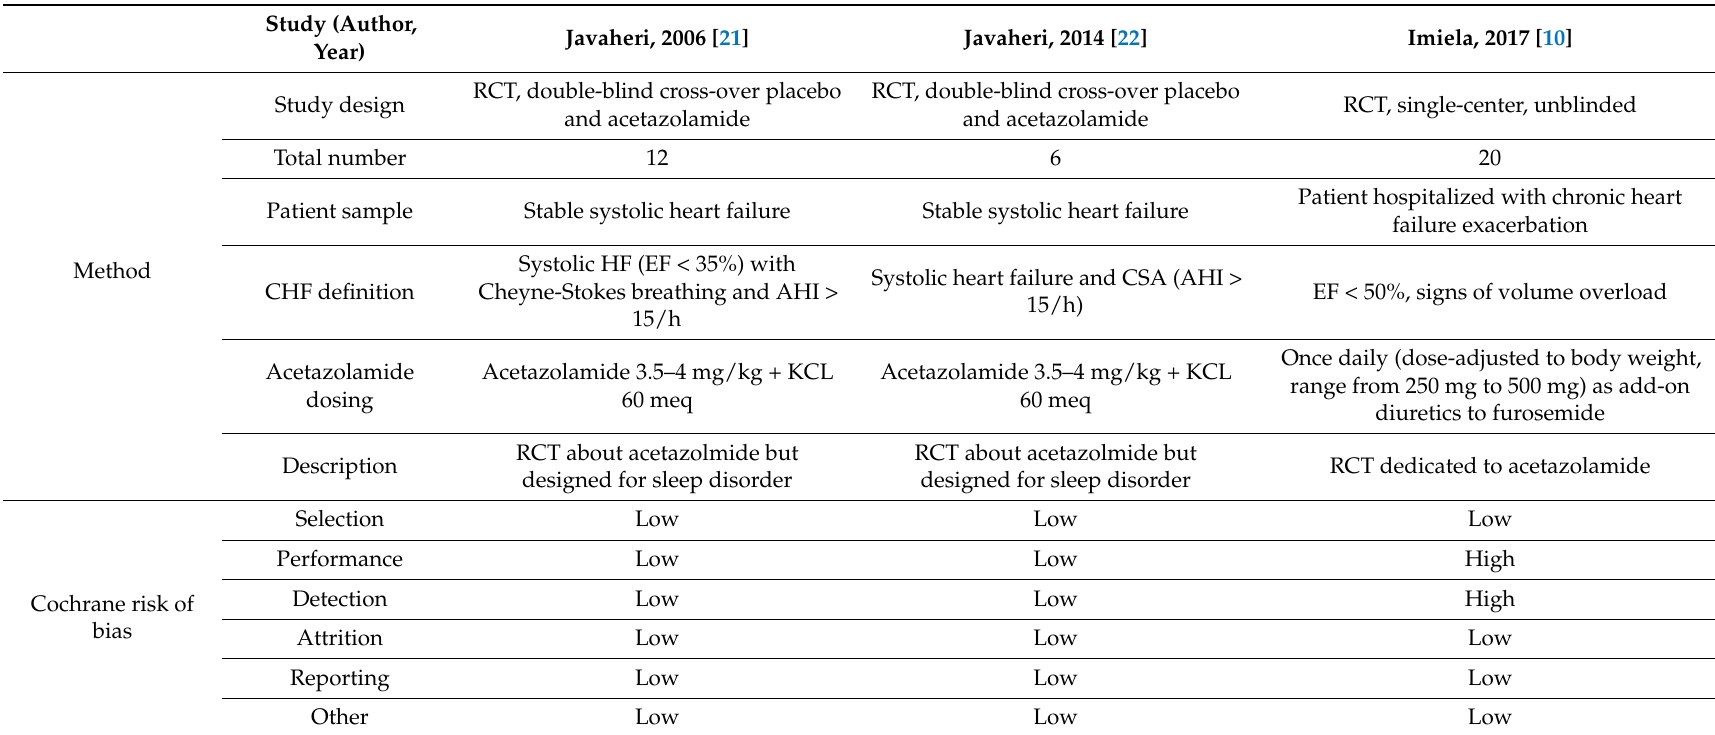
Table 1. Main characteristics of the RCTs included in the meta-analysis of acetazolamide therapy in heart failure